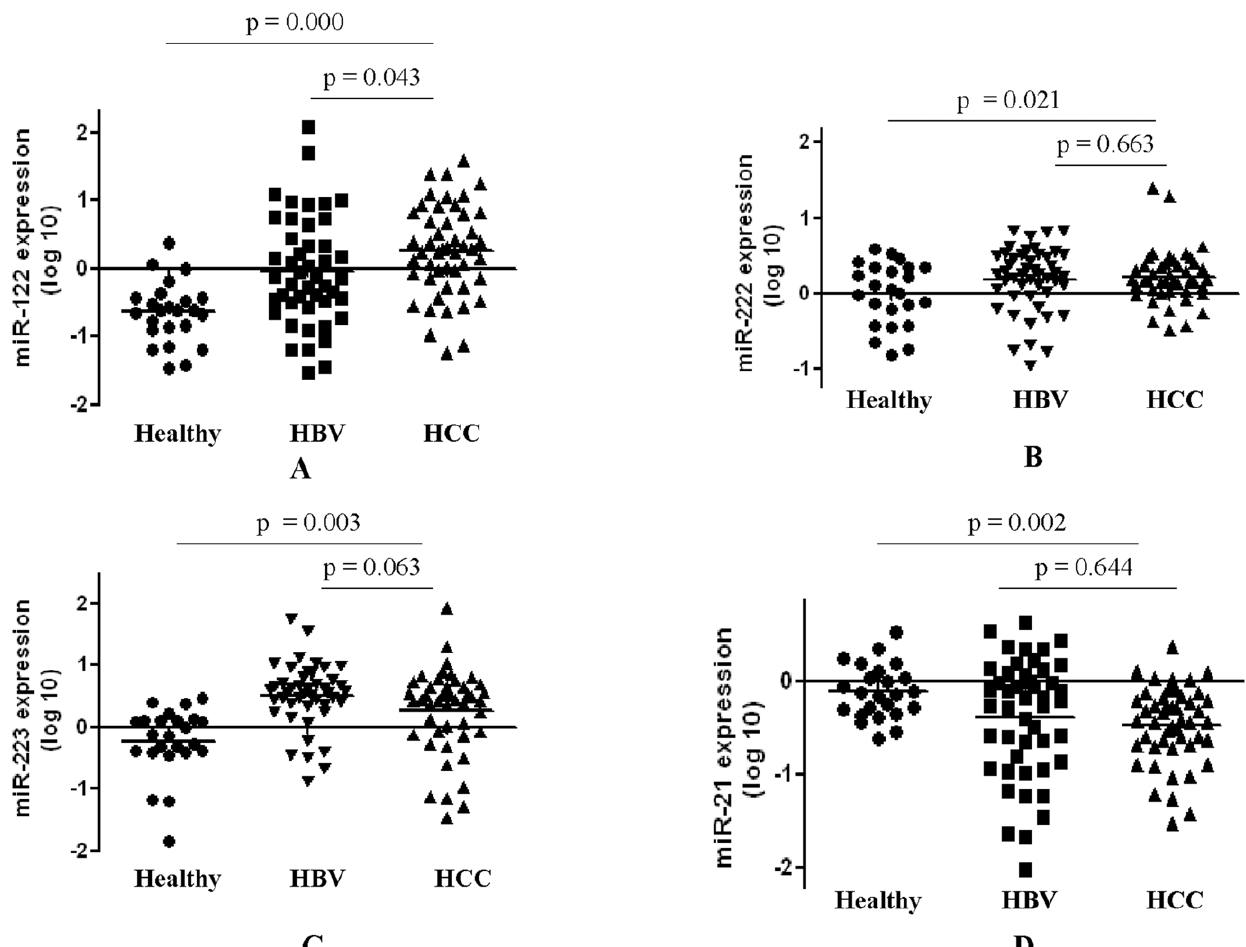
Figure 2. Expression levels of miRNAs in serum of HCC patients, HBV patients without HCC and healthy subjects. Levels of miR-122 (A), miR-222 (B), miR-223 (C) and miR-21 (D) were measured in serum of 48 HCC patients (n=48), HBV patients without HCC (n=48) and healthy subjects (n=24) by RT-qPCR. Levels of miR-122 were significantly higher in HCC patients than disease controls (p , 0.05) or healthy controls (p , 0.001). Although levels of miR-222 and miR-223 were also significantly elevated in HCC patients than in healthy controls (p , 0.05), no significant difference was observed for these two miRNAs between HBV subjects with and without HCC (p . 0.05). Levels of miR-21 were reduced in HCC patients than in healthy controls (p , 0.05), no significant difference was observed for miR-21 between HBV subjects with and without HCC (p .